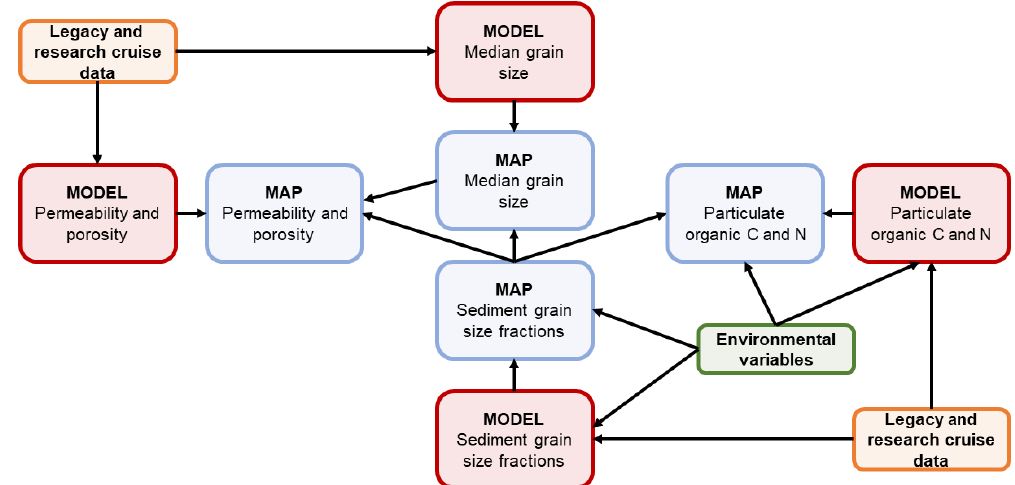
Figure 5. Illustration of the workflow described in this chapter. Legacy and research cruise data (orange boxes) were used in conjunction with mapped environmental variables (green boxes) to fit models of seabed sediment grain size and geotechnical properties and organic carbon and nitrogen content. Full-coverage quantitative maps of these properties (blue boxes) were generated by using mapped environmental variables and sedimentary maps created earlier in the workflow as the substrate from which to generate predictions from the fitted